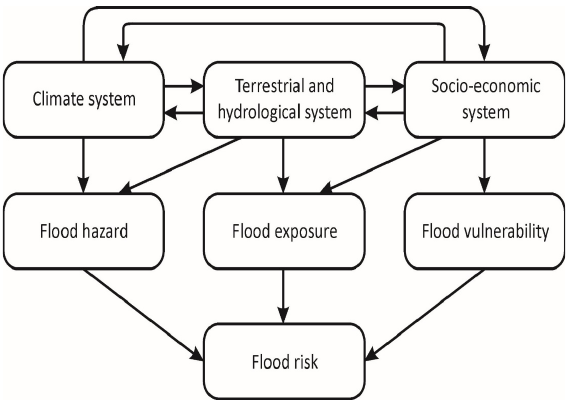
Figure 2. Components of flood risk [3].